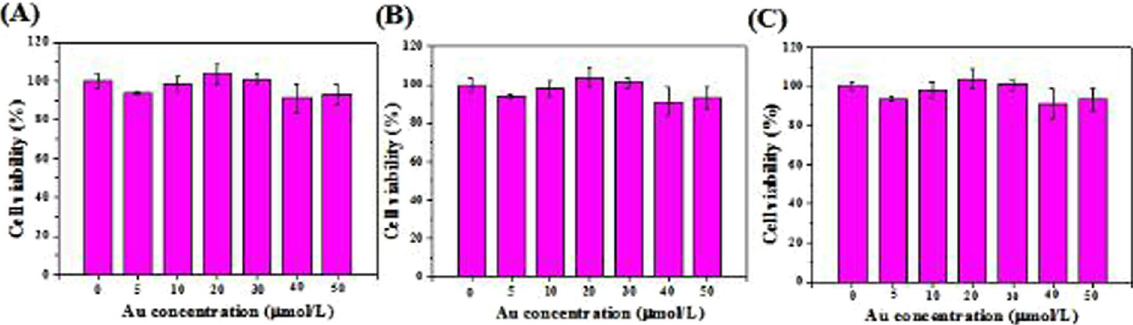
Figure 6. In vitro cytotoxicity studies of the PEG-CSAuNAs performed on HK-2 cell lines by CCK-8 assays. Cells were exposed to different concentrations of the PEG-CSAuNAs (5~50 µ mol/L Au) for ( A ) 6 h, ( B ) 12 h and ( C ) 24 h, respectively.